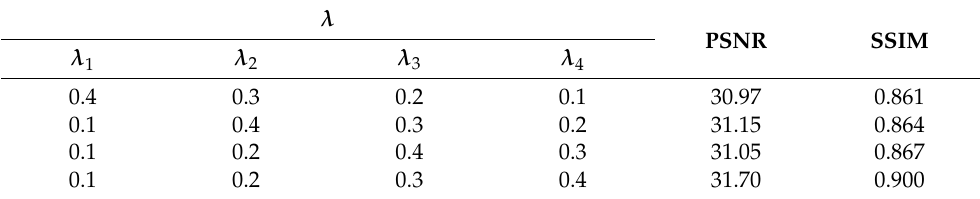
Table 7. The selection of loss function